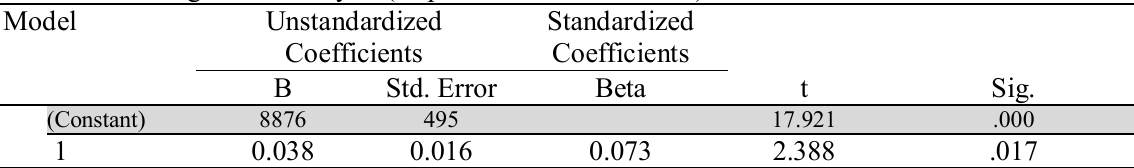
The results of regression analysis (Dependent Variable: ROA)